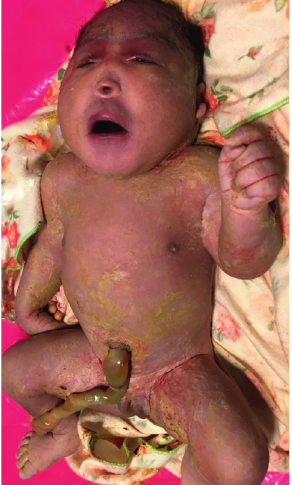
Figure 2: Neonate with cebocephaly (microcephaly, hypotelorism, single nostril, a monkey-like head) and without other external abnormalities.